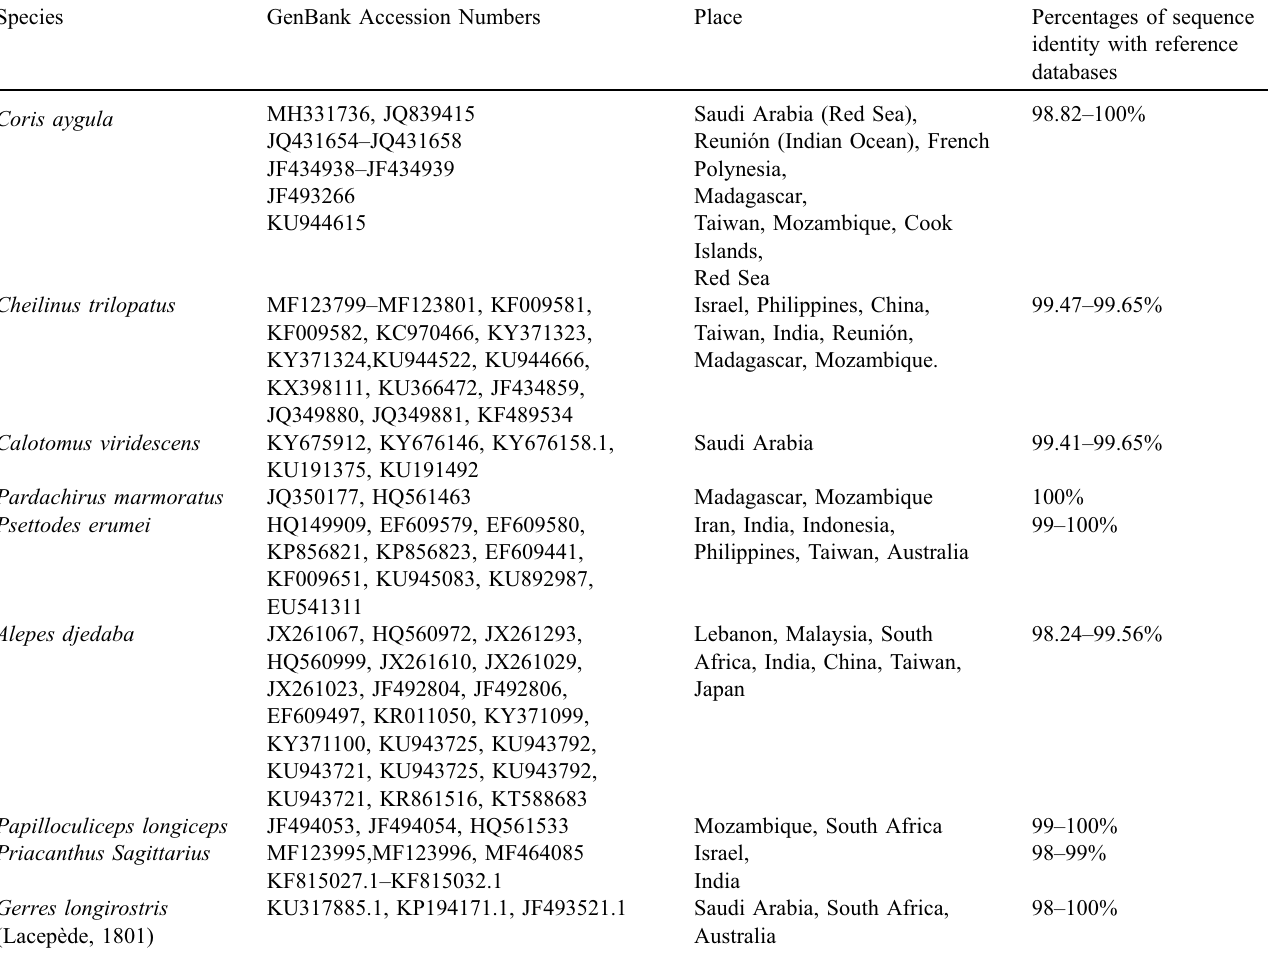
Table 2. COI sequences identities among the samples collected from Suez city fi sh market in the current study and their closest counterparts from different areas in the